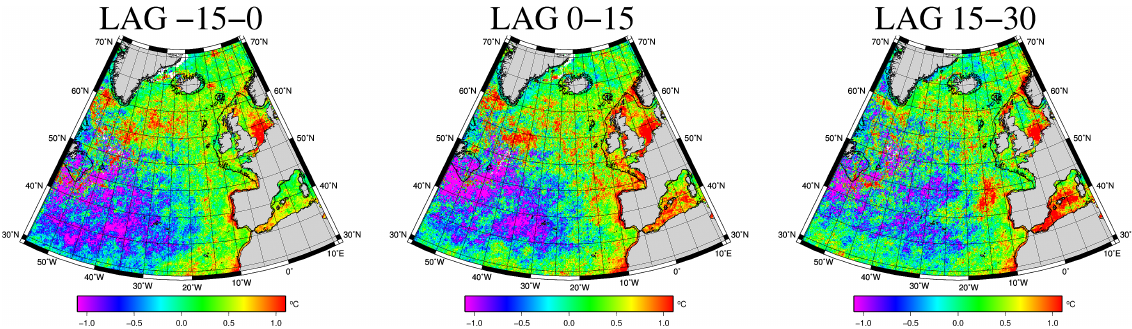
Fig. 11. Composite results based on the IPC-Navidad time series shown in Fig. 7 for the flag 7 un-reconstructed Pathfinder v5.2 SST anomaly data. − 15–0, 0–15 and 15–30day lag ranges are taken into